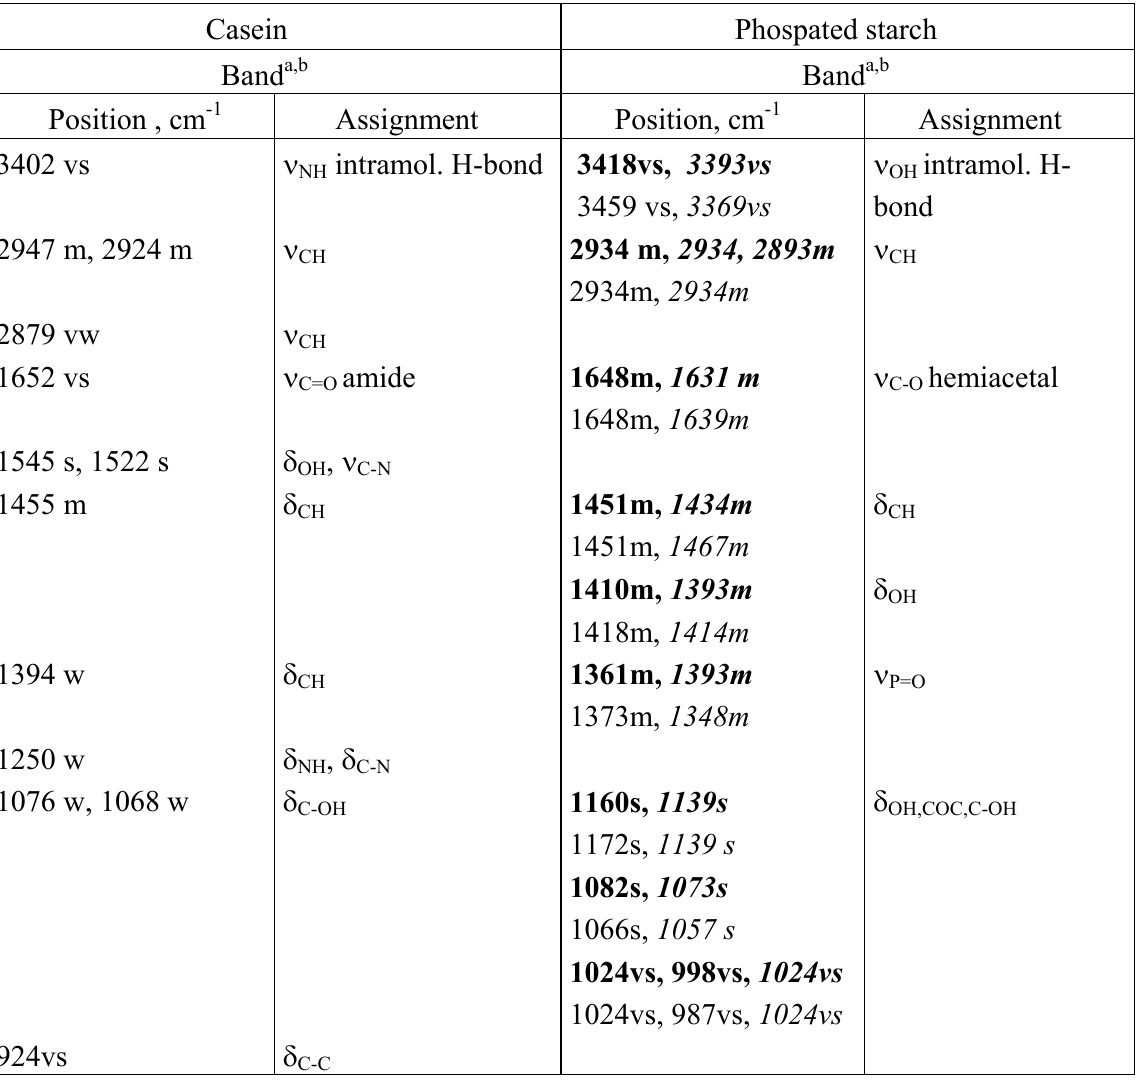
Table 4. IR spectral characteristics of casein, GPCS, PPCS, GPWCS and